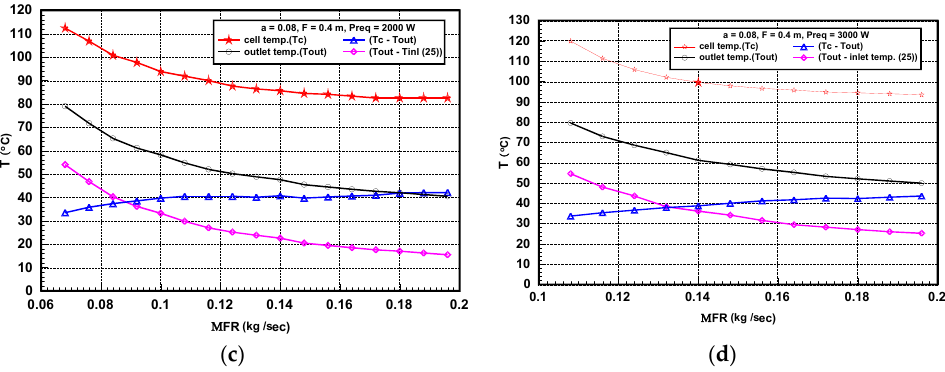
Figure 17. Effective temperatures of a CPVT collector plotted against the mass flow rate for the same focus distance and receiver width, ( a – d ) different required power. Simulation plots for different effective temperature in the CPVT collector versus the mass flow rate of the cooling water at a zero reduced temperature ( T amb = T inl ) for a certain required power (500 W) and different focus distance ( F ) are shown in Figures 18a–c. These figures indicate an increase in the effective temperature as a result of increasing focus distances. This increase in the focus distance leads to increases in the concentrating area, most probably due to the increase in the incoming radiation flux that is received by the receiver.